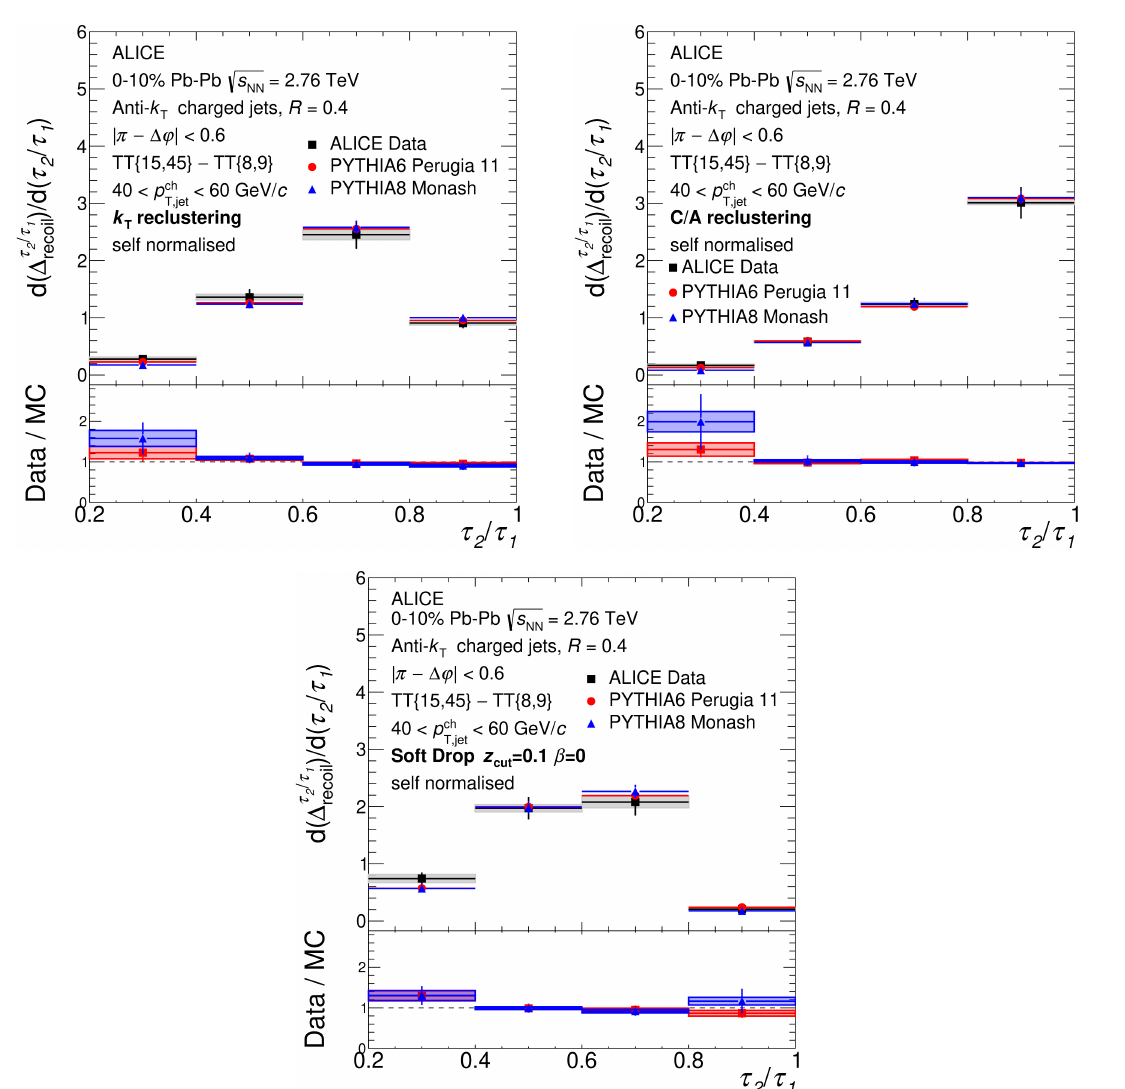
Figure 7 . Fully corrected τ 2 /τ 1 distributions, measured with the k T , C/A and C/A with Soft √ Drop grooming algorithms, in Pb-Pb collisions at s NN = 2 . 76 TeV for jets with R = 0 . 4 in the jet p ch interval of 40 – 60 GeV /c , are shown. The systematic uncertainties are given by the grey T , jet boxes. The results are self normalised and compared with PYTHIA6 Perugia 2011 and PYTHIA8 Monash. The uncertainties presented for the PYTHIA distributions are purely